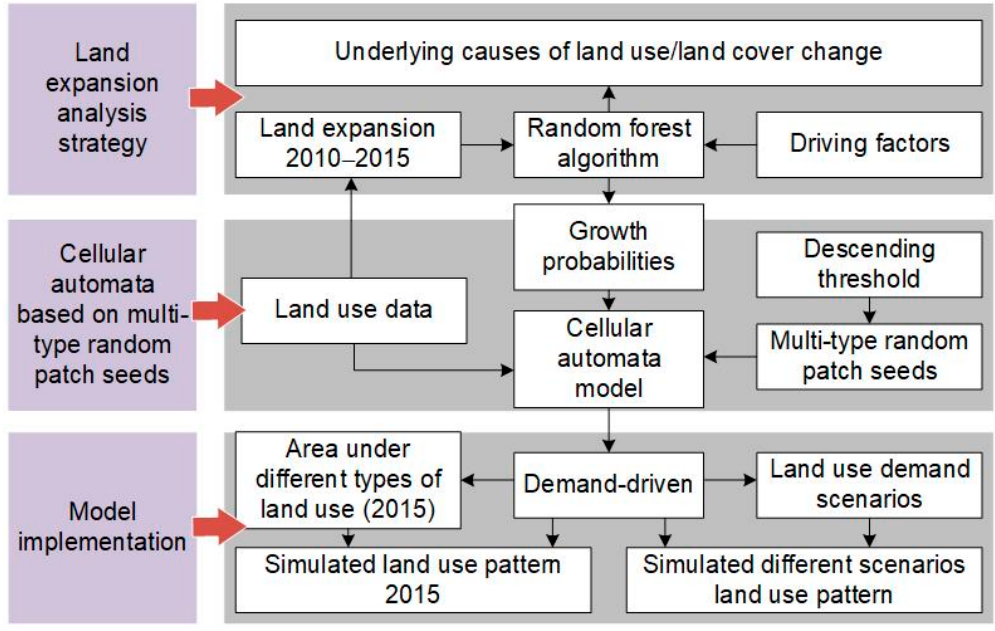
Figure 2. Framework of the patch-generating land use simulation model and the modeling workflow.